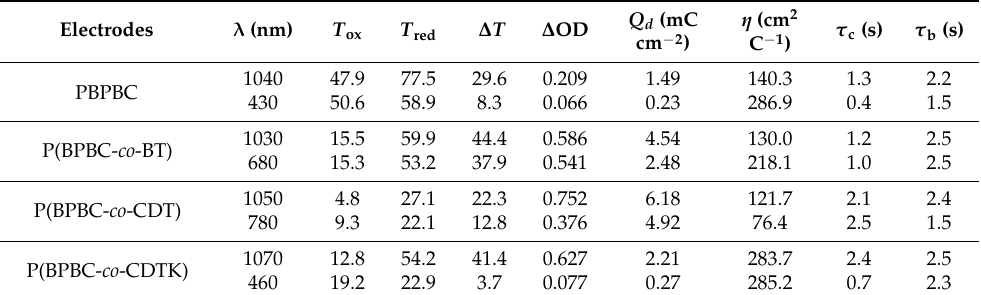
Figure 8. Optical contrast of ( a ) PBPBC, ( b ) P(BPBC- co -BT), ( c ) P(BPBC- co -CDT), and ( d ) P(BPBC- co - CDTK) in 0.2 M LiClO 4 of ACN/DCM solution (ACN/DCM = 4:1, by volume) with a residence time of 5 s. Table 3. Optical and electrochromic switching properties investigated at selected wavelengths for the